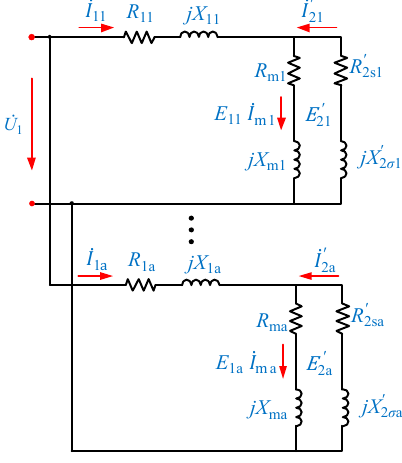
Figure 7. ECM of motors with a-parallel windings.